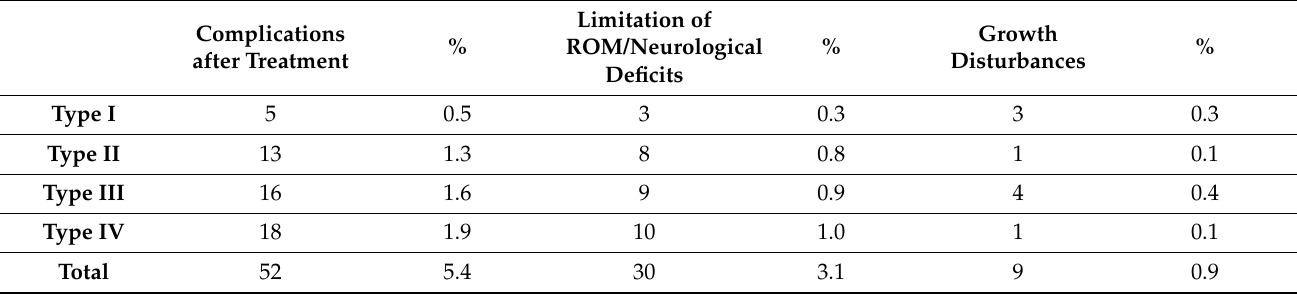
Table 7. Adverse events according to fracture